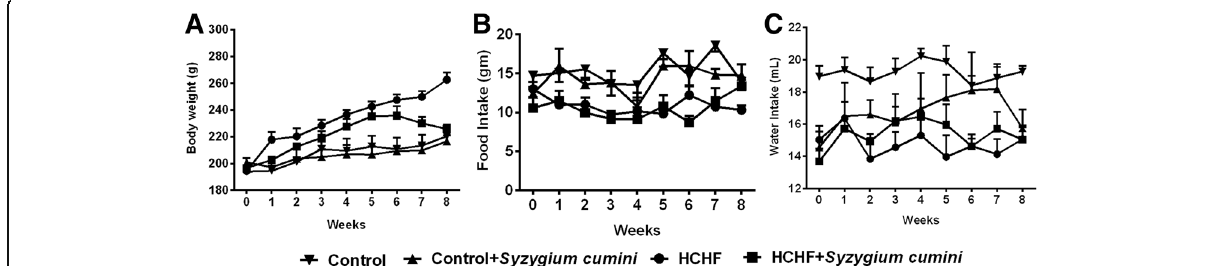
Fig. 2 Effect of Syzygium cumini seed powder supplementation on body weight ( a ), food ( b ) and water ( c ) intake in high fat diet induced obese rats. Values are presented as mean ± SEM. n = 7